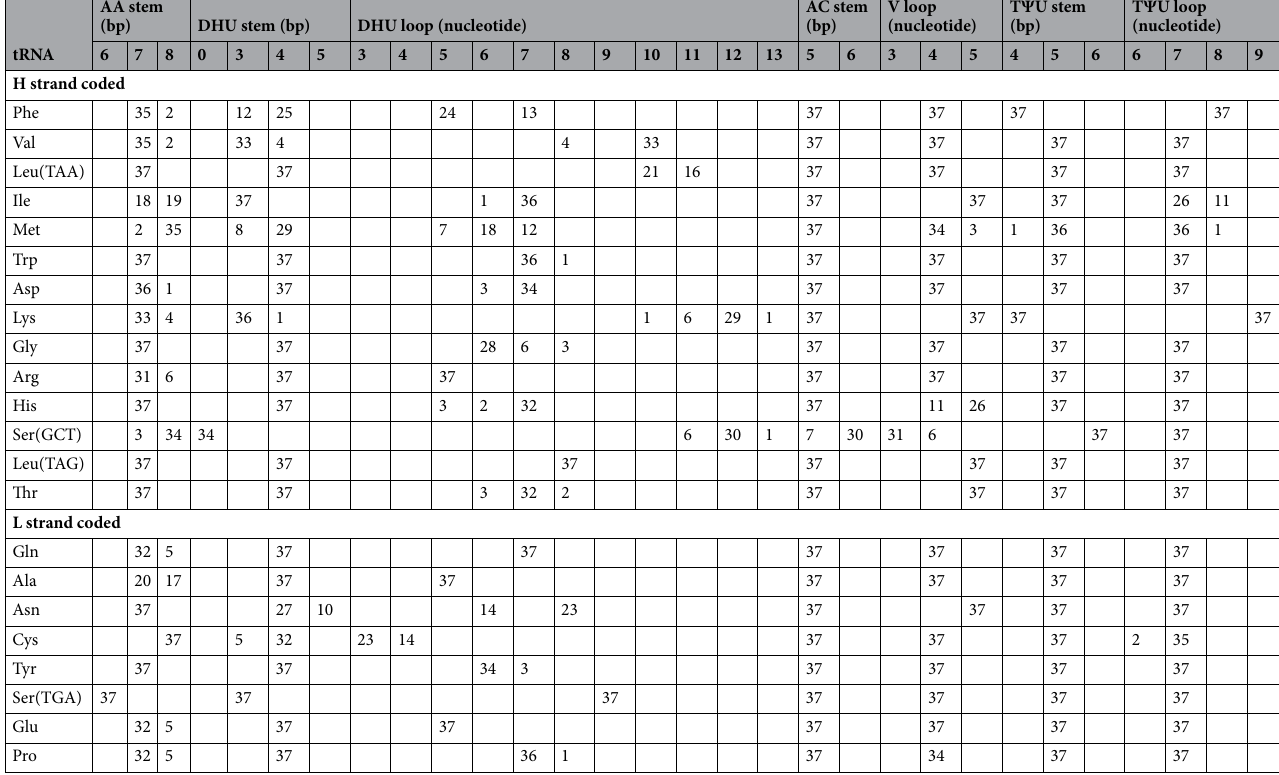
Table 2. Size of stems and loops of 22 tRNA genes in the mitogenomes of 37 species of